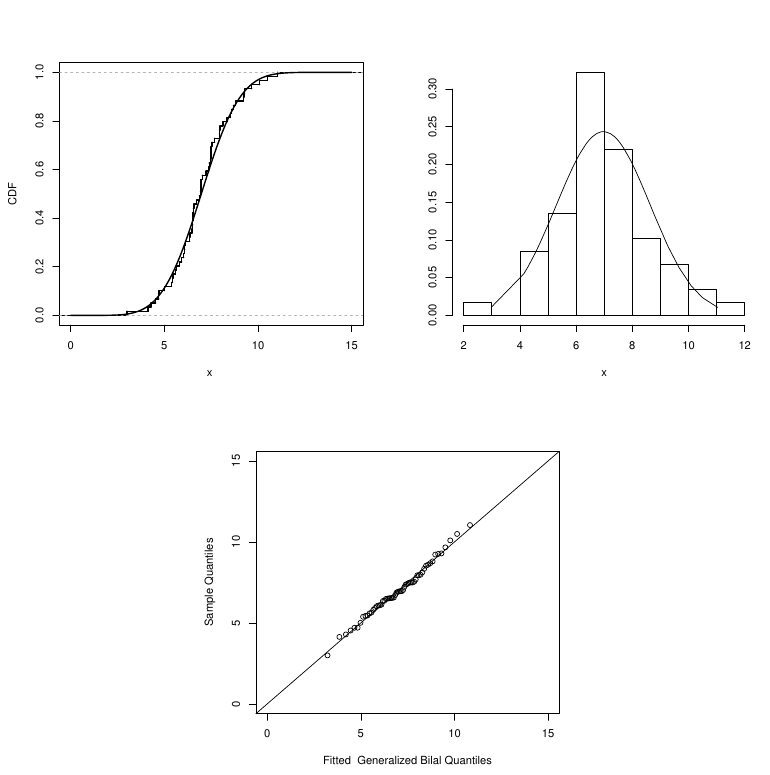
Figure 5 – Empirical and theoretical cdf (upper left), fitted pdf plot (upper right) and Q-Q plot for the real data set